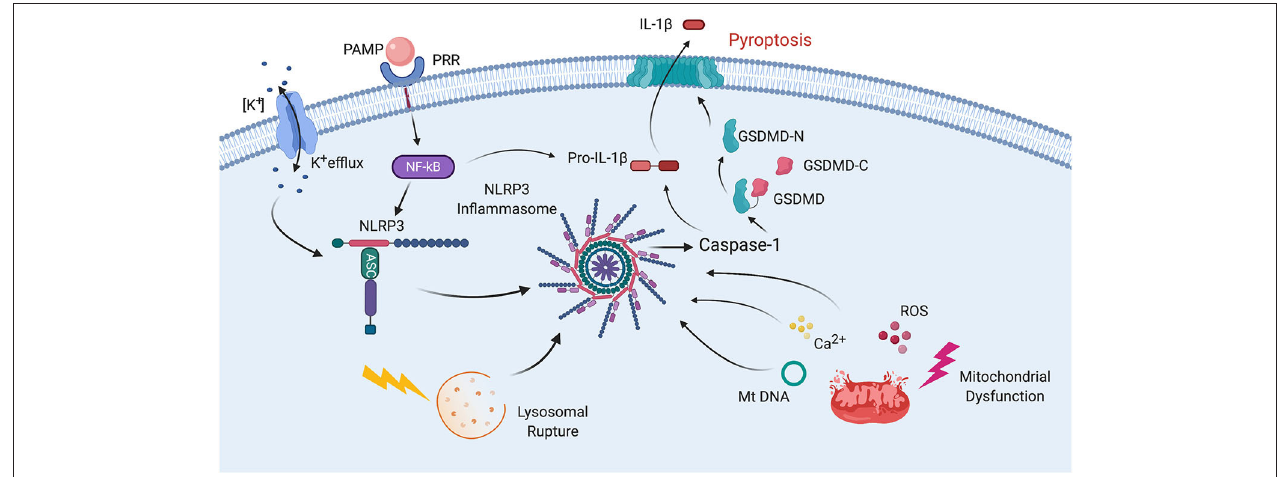
FIGURE 2 | Mechanisms of inflammasome activation. Inflammasome activation in general relies on two signals for its activation. First, a PAMP binds to a PRR resulting in synthesis of NLRP3 and pro-IL-1 β . Then a second signal leads to inflammasome assembly, leading to the activation of caspase-1, processing of pro-IL-1 β into IL-1 β and pyroptosis. The second signal may come from a variety of pathways including K + efflux. Lysosomal rupture or mitochondrial dysfunction. Mitochondrial dysfunction results in release of ROS, Ca 2 + and mitochondrial DNA (mtDNA), all of which have been shown to activate the inflammasome. Pyroptosis occurs as a result of caspase-1-mediated cleavage of GSDM-D at the linker region of GSDM-D. Following GSDM-D cleavage, the amino terminus of GSDM-D (GSDM-D-N) forms a non-selective pore at the cell membrane through which IL-1 β is then released.